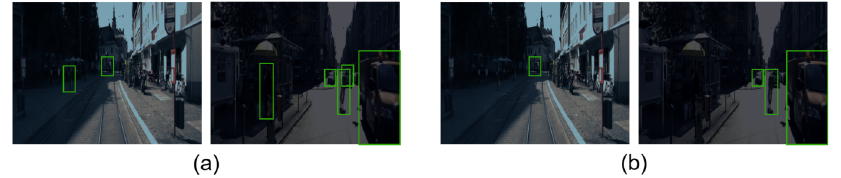
Figure 8. Target detection in night frame with ( a ) sensor fusion algorithm and ( b ) only